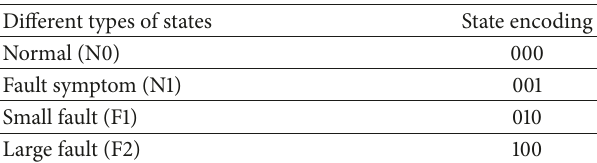
Table 1: Description of adhesion state of locomotive wheel rail. Table 2: State